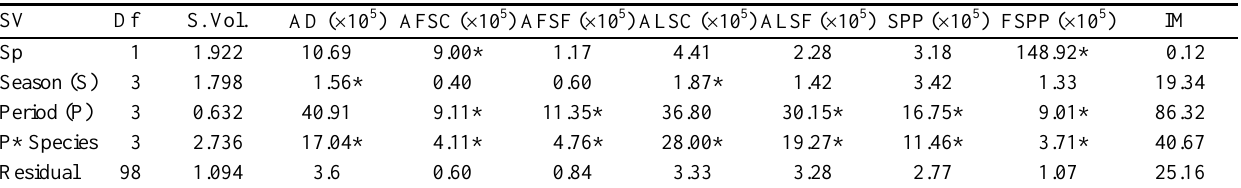
Table 5. Degrees of freedom (Df) and Mean-Squares values of the effects for various reproductive traits of dairy bulls obtained through least squares analyses of variance SV